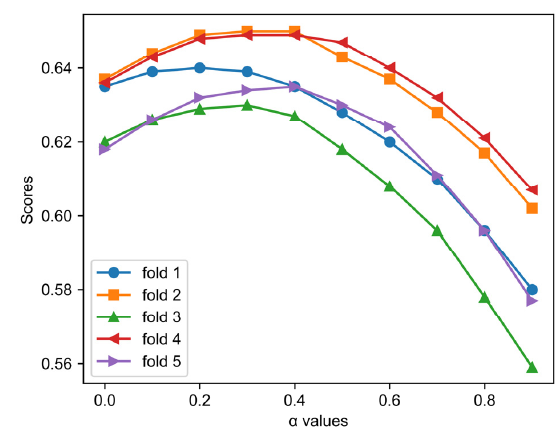
Figure 2. The cost-weighted accuracy ( CWAcc ) scores of the model under different values of α . Each line in this figure corresponds to a model trained in a certain cross-validation fold.